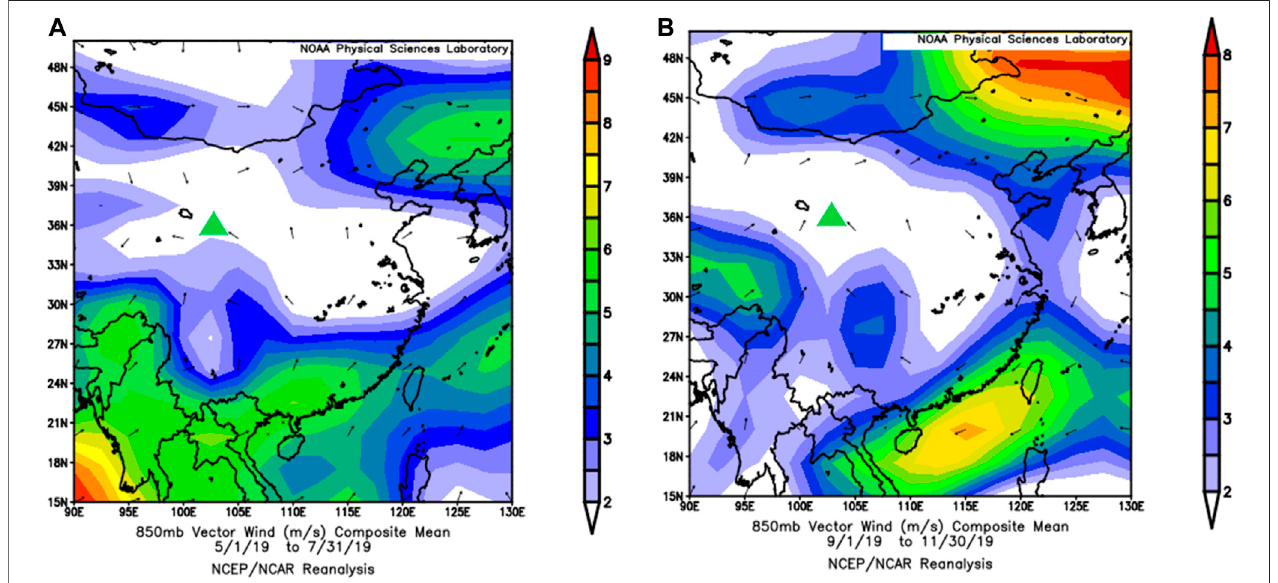
FIGURE 12 | Backward trajectory clustering of the water vapor in Lanzhou during the 2019 precipitation period. The black fi ve-pointed stars represent sampling points, the red line represents 1500 m air mass trajectories, the green line represents 3,000 m air mass trajectories, and the blue line represents 3,300 m air mass trajectories. Conditions on (A) 24 May, (B) 15 June, (C) 27 June, (D) 9 July, (E) 12 September, (F) 16 September, (G) 24 October, and (H) 5 November.